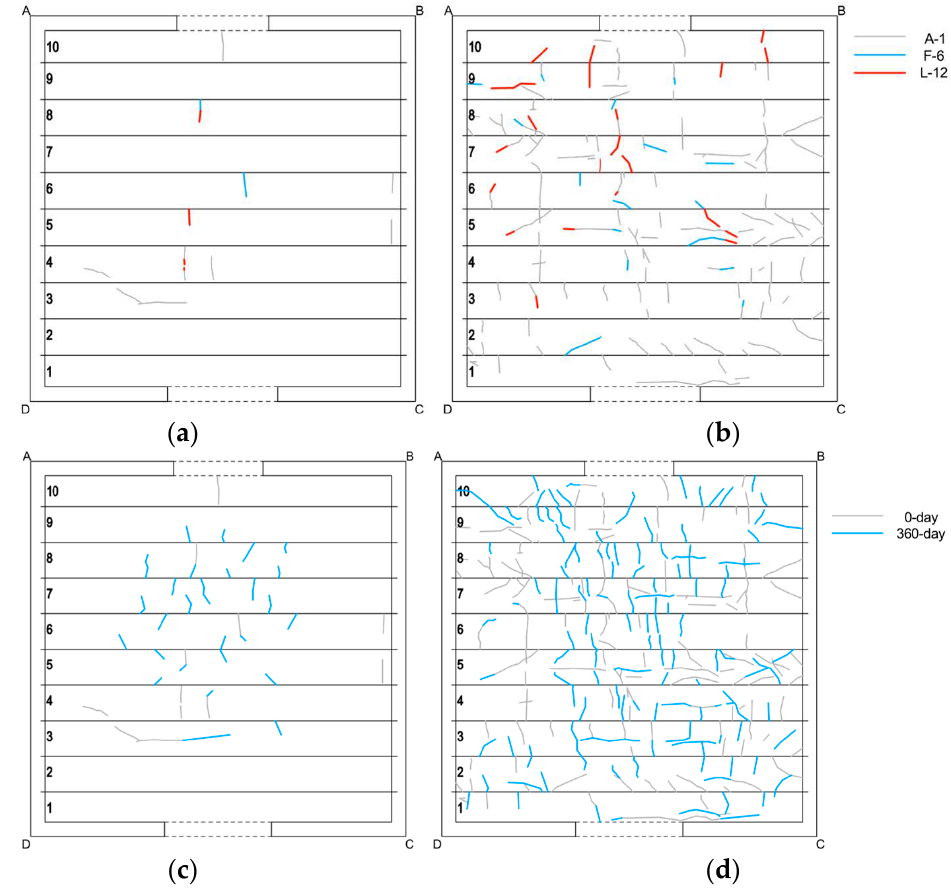
Figure 13. Crack patterns on bottom surface: ( a ) LGR 0-day; ( b ) LGF 0-day; ( c ) LGR 360-day (scheme L-12); ( d ) LGF 360-day (scheme L-12).